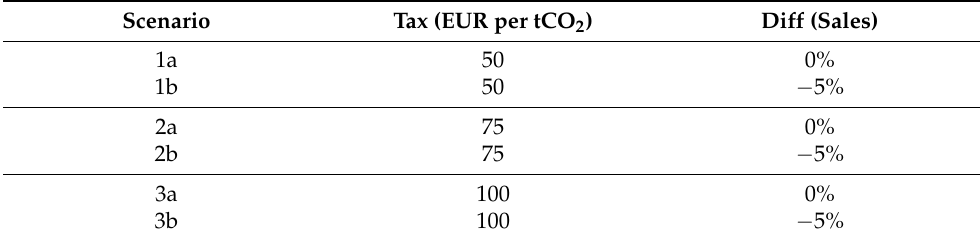
Table 3. Scenario for stress tests.